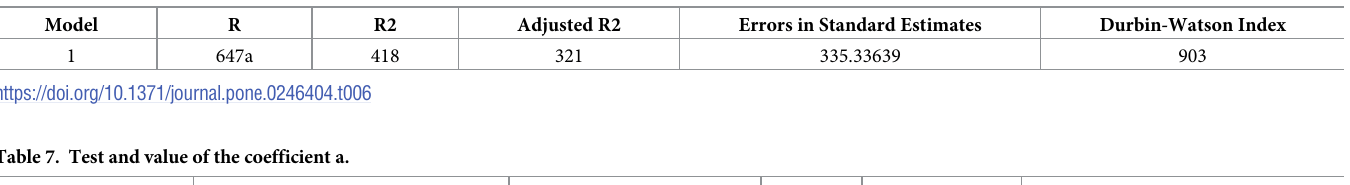
Table 6. Summary of the number of performing arts venues model.